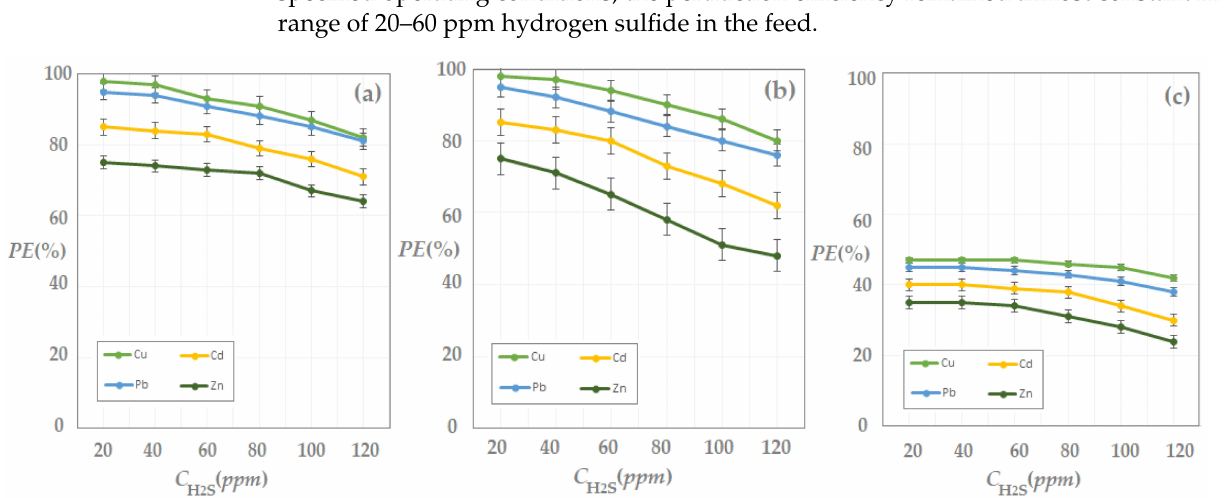
Figure 13. Hydrogen sulfide pertraction efficiency ( PE %) vs. hydrogen sulfide concentration in gas mixture: nitrogen ( a ); methane ( b ), and carbon dioxide ( c